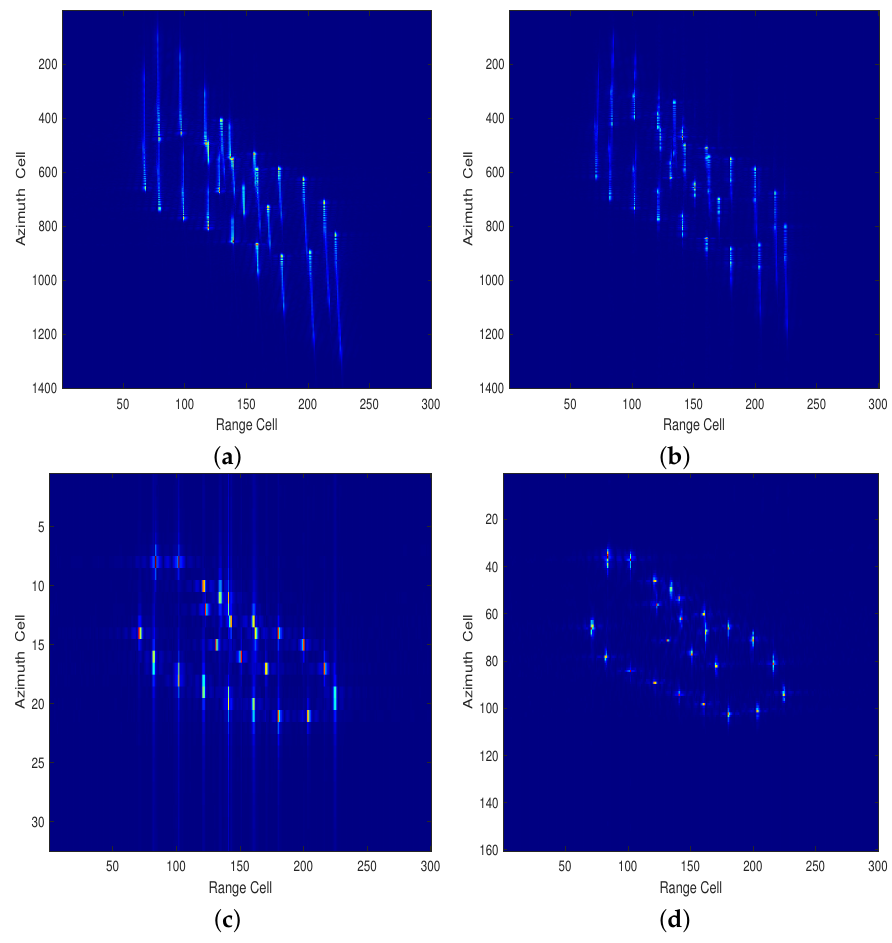
Figure 7. The performance of the proposed method on simulated data. ( a ) SAR subimage ( b ) RD imaging after motion compensation. ( c ) RD imaging after optimal imaging time selection. ( d ) IAA imaging after optimal imaging time